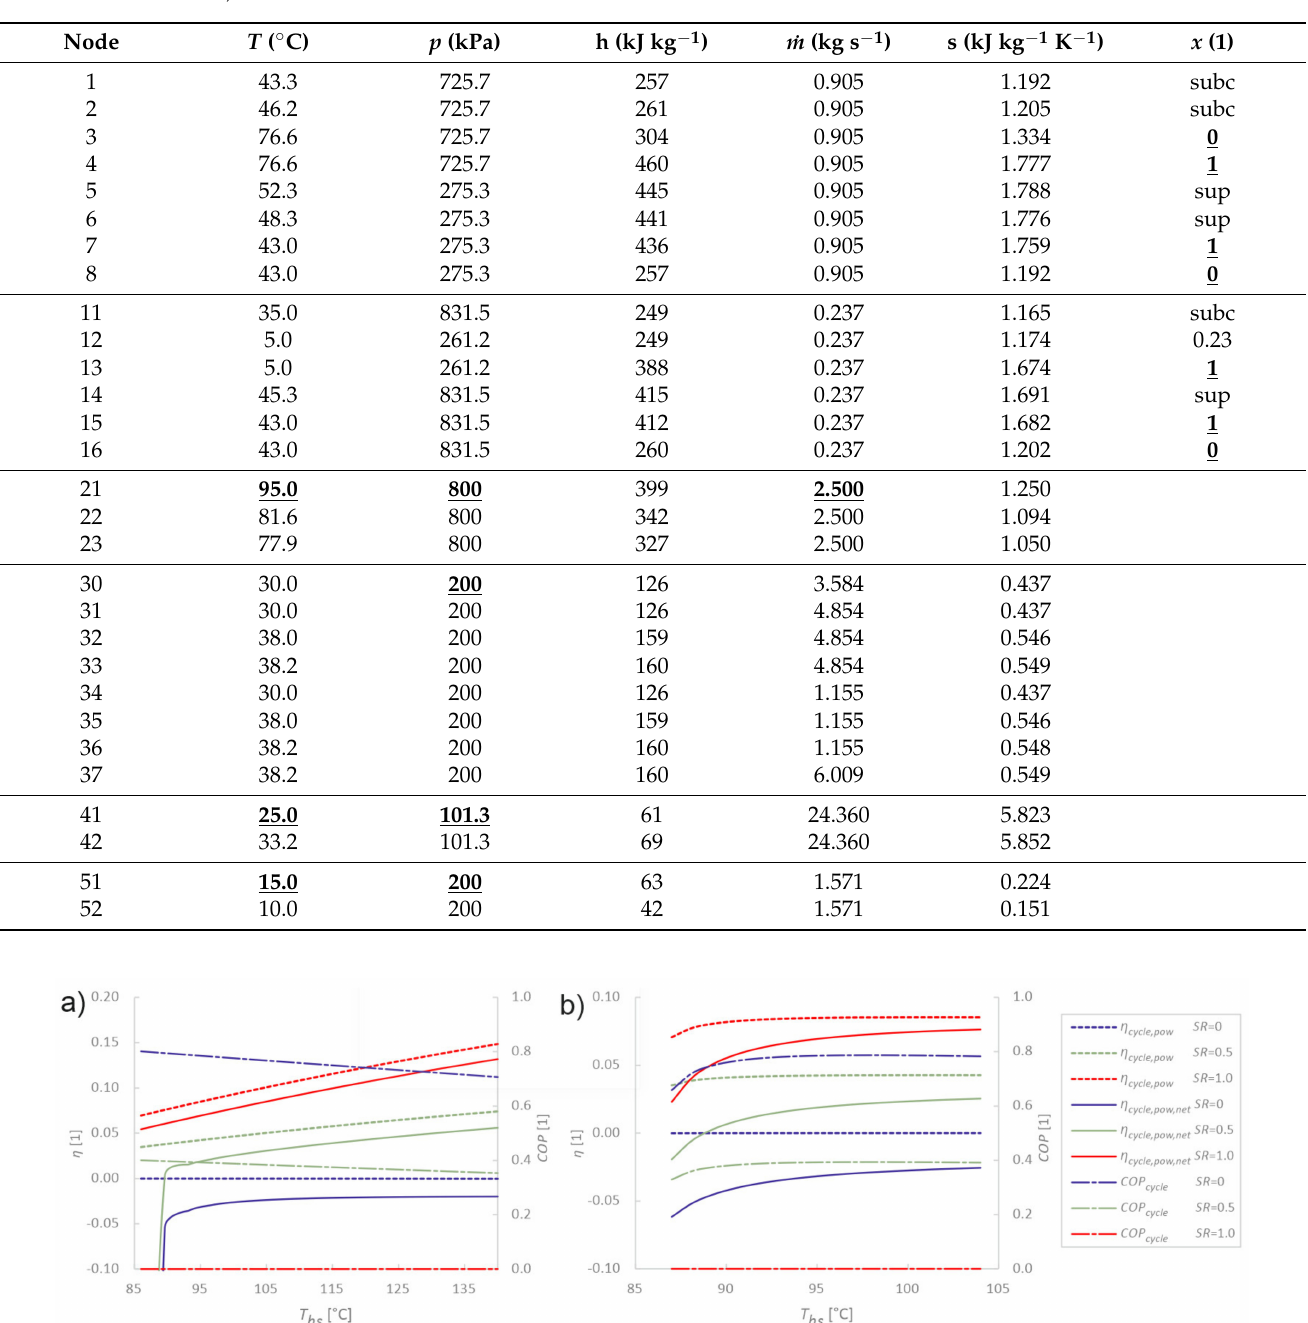
Table A4. Parameters of the ORC-VCC in its nodes after optimisation for heat source utilisation (imposed values in underscored bold).